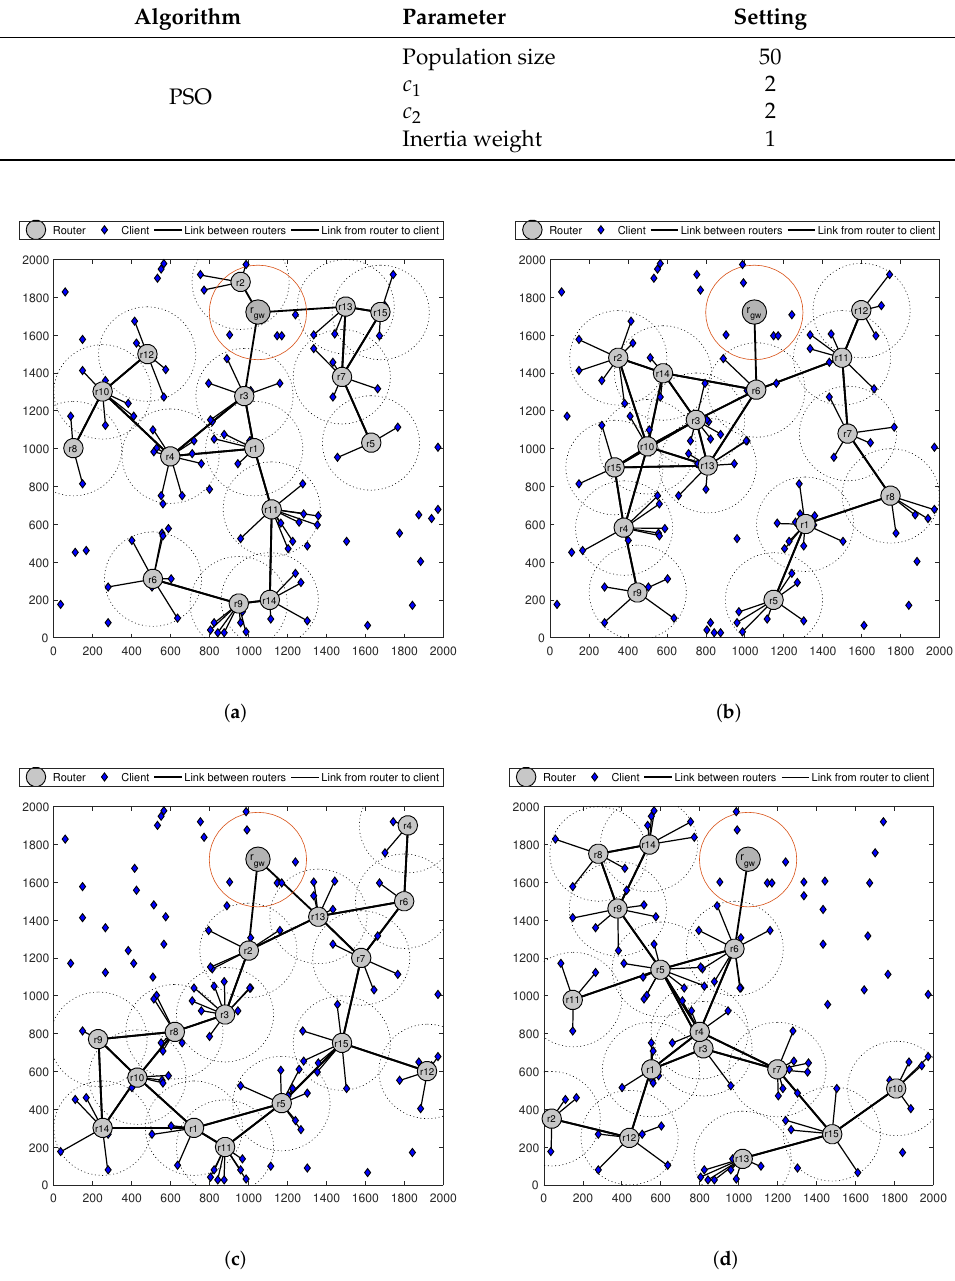
Figure 4. The network topologies of WMN obtained using algorithms MVO, WOA, GA and PSO. ( a ) GA. ( b ) PSO. ( c ) WOA. ( d )